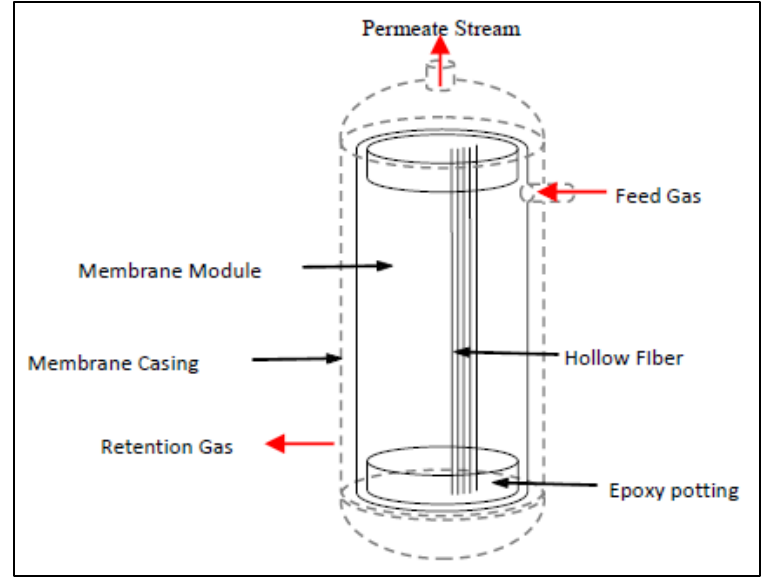
Figure 1. Membrane module used in this experiment.